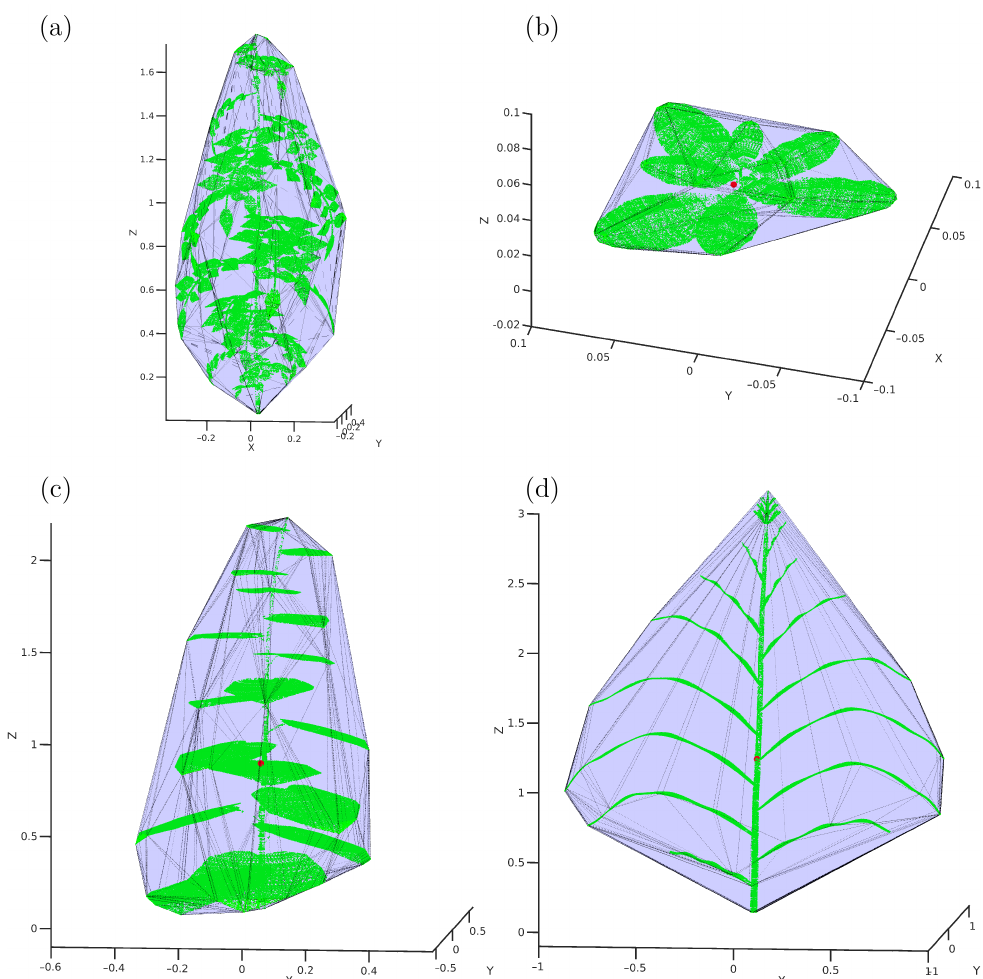
Figure 5. Visualization of the scanned point cloud (green dots) of the complete (initial) plant and the convex hull drawn as transparent blue for all four plant species used in this study: ( a ) tomato, ( b ) arabidopsis, ( c ) greenhouse cucumber, and ( d )